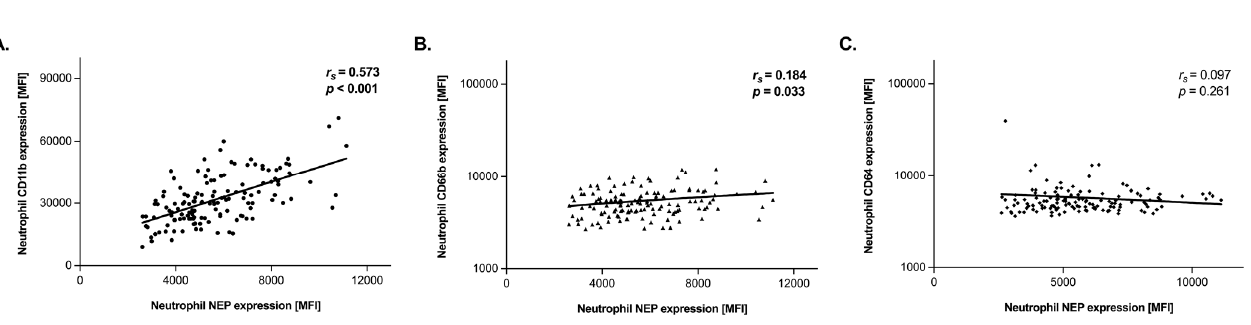
Figure 2. Relationship of neutrophil activation/maturation markers and heart failure severity. Scat- ter plots with linear regression analysis and the Spearman’s rho correlation coefficient for mean fluorescence intensities (MFI) of neutrophil CD11b, CD66b and CD64 expression with N-terminal pro B-type natriuretic peptide (NT-proBNP), as well as group comparisons between New York Heart Association (NYHA) class, are shown. Comparison between groups has been assessed by us- ing the Kruskal–Wallis test, level of significance is indicated in the respective plots.